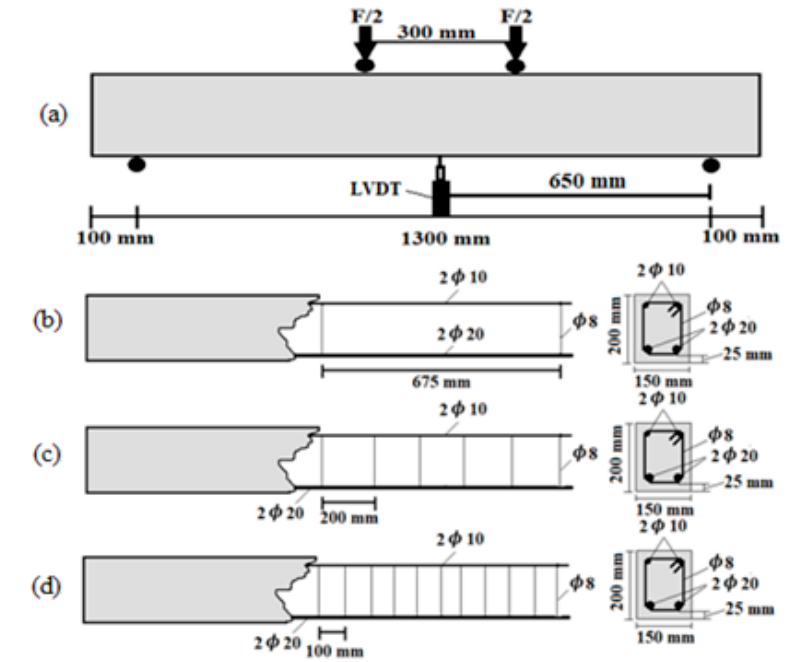
Figure 9. Geometry of the beams and arrangement of the rebars: ( a ) boundary condition, ( b ) specimen without transverse reinforcement, ( c ) specimens with a 200 mm transverse reinforcement spacing and ( d ) specimens with a 100 mm transverse reinforcement spacing. (Note: LVDT: Linear variable di ff erential